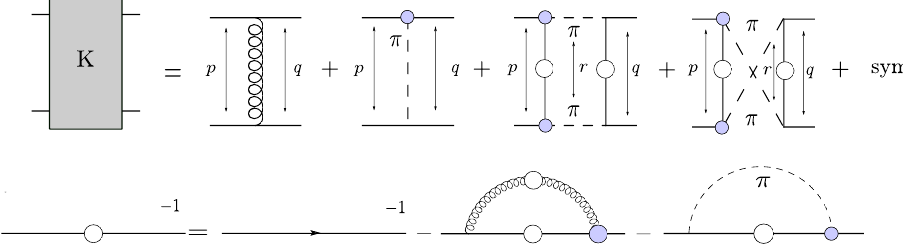
Figure 3. Truncations used herein for the Bethe-Salpeter interaction kernel K (upper diagram) and the quark Dyson-Schwinger equation (lower diagram). In the upper diagram, the terms on the right- hand side correspond to the gluon, pion exchange, and s- and u-channel pion decay contributions to the truncation, respectively. The s- and u-channel pion decay terms do not contribute to the quark Dyson-Schwinger